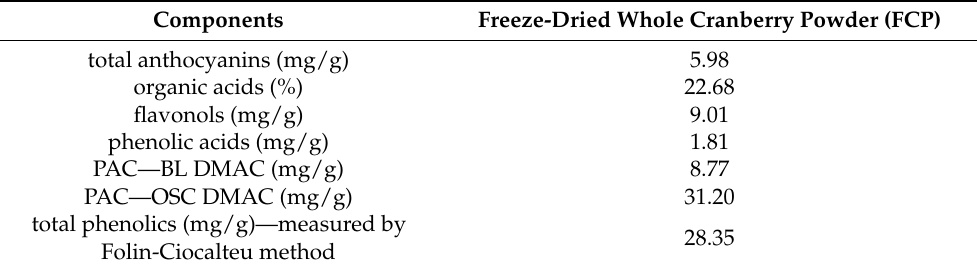
Table 1. Composition of the freeze-dried whole cranberry powder (FCP). PAC: proanthocyanidin; BL-DMAC: Brunswick Labs 4-dimethylaminocinnamaldehyde method, with procyanidin A2 dimer as standard; OSC DMAC: Ocean Spray Cranberries 4-dimethylaminocinnamaldehyde method, with proprietary PAC extract from cranberries as